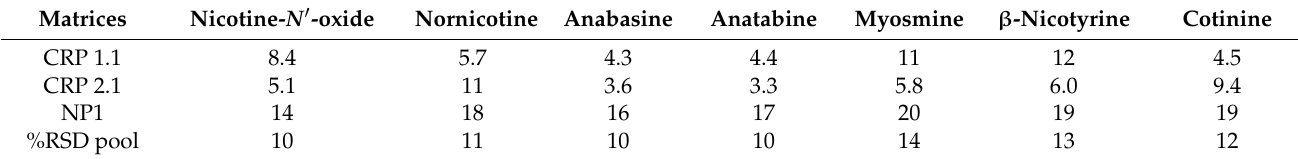
Table 5. Within-laboratory precision (%RSD).